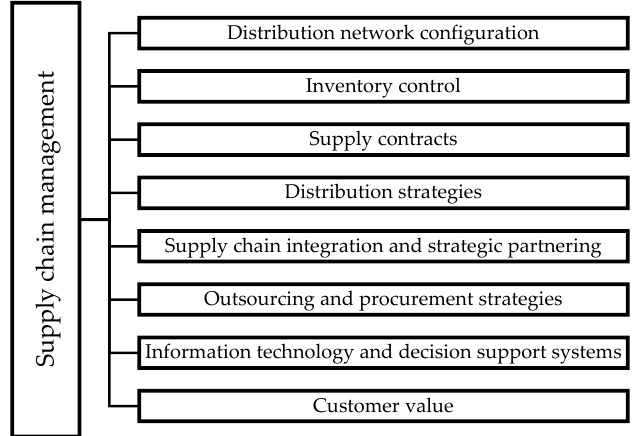
Figure 3. Key aspects of supply chain management.